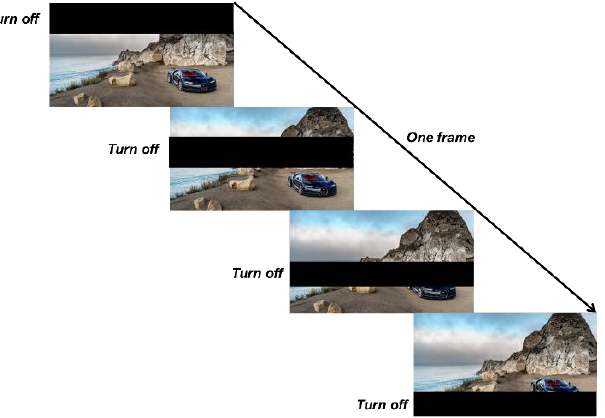
Figure 5. Concept of the proposed scanning black frame insertion method.